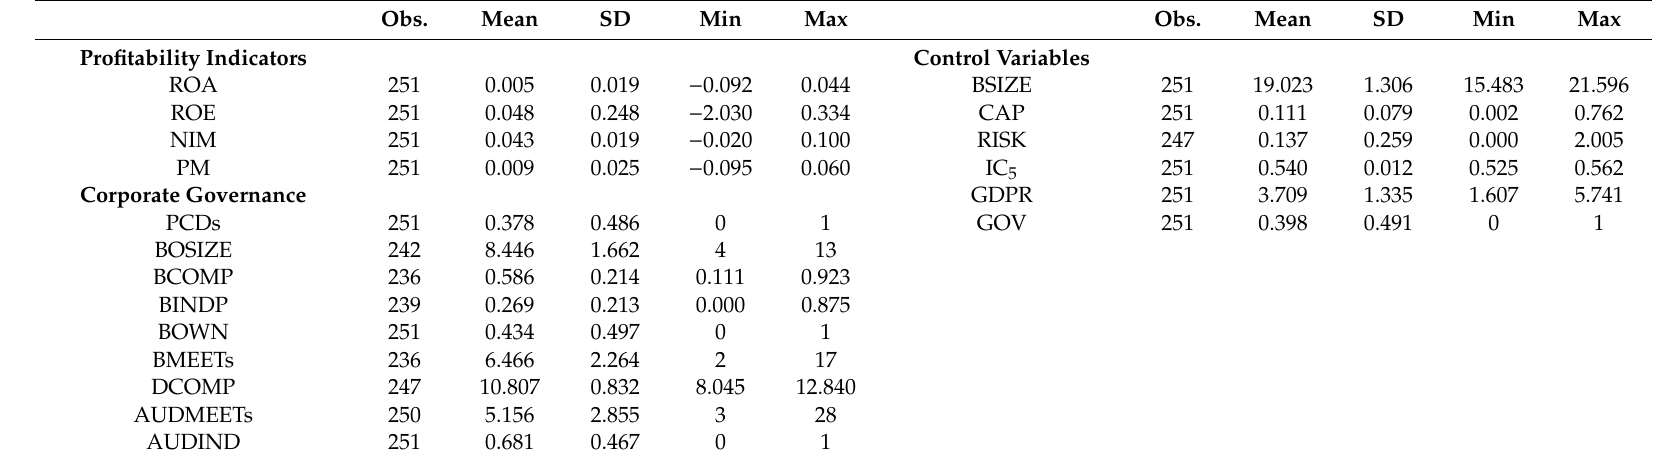
Table 4. Descriptive statistics. Obs—observed; Min—minimum; Max—maximum.